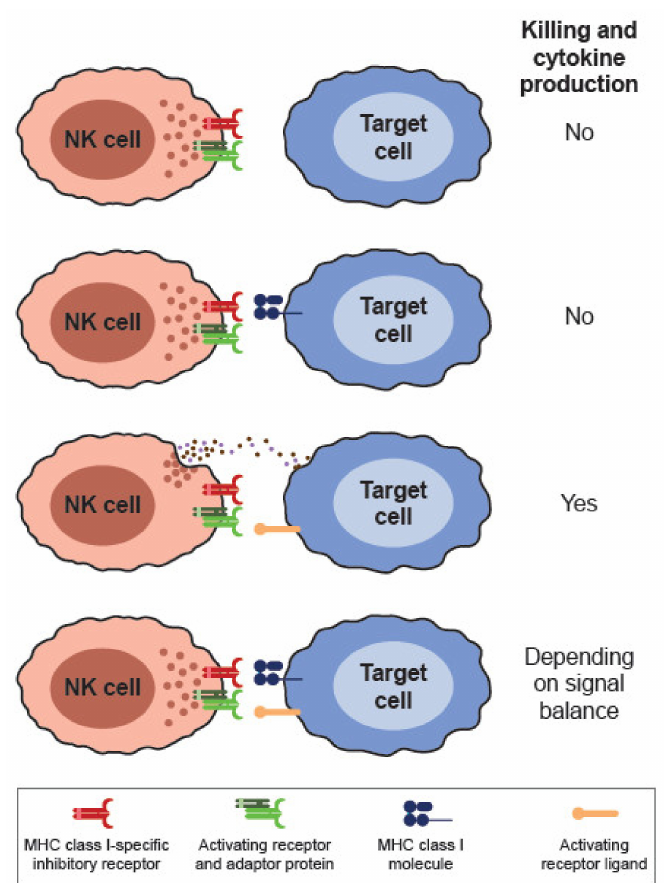
Figure 2. Activating and inhibitory signaling balance determines NK cell killing and cytokine production. Target cells expressing ligands for activating receptors trigger NK activation. When target cells also express ligands for inhibitory receptors, NK cell activation will depend on the signal